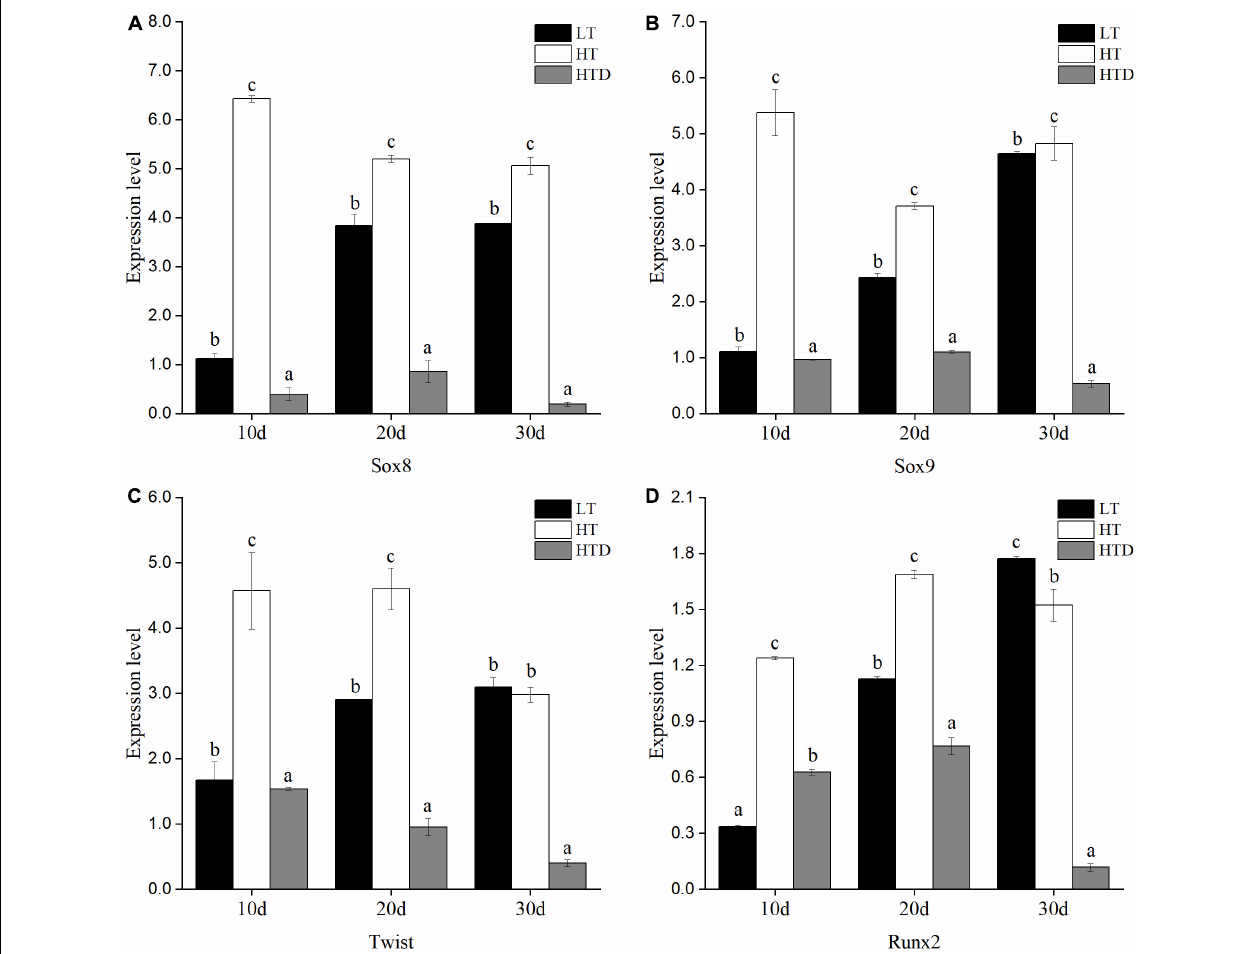
FIGURE 7 | The expression levels of transcription factors ( A : Sox8, B : Sox9, C : Twist, D : Runx2) in the spine of juvenile T. ovatus (LT, low temperature group; HT, high temperature group; HTD, high temperature deformity group).